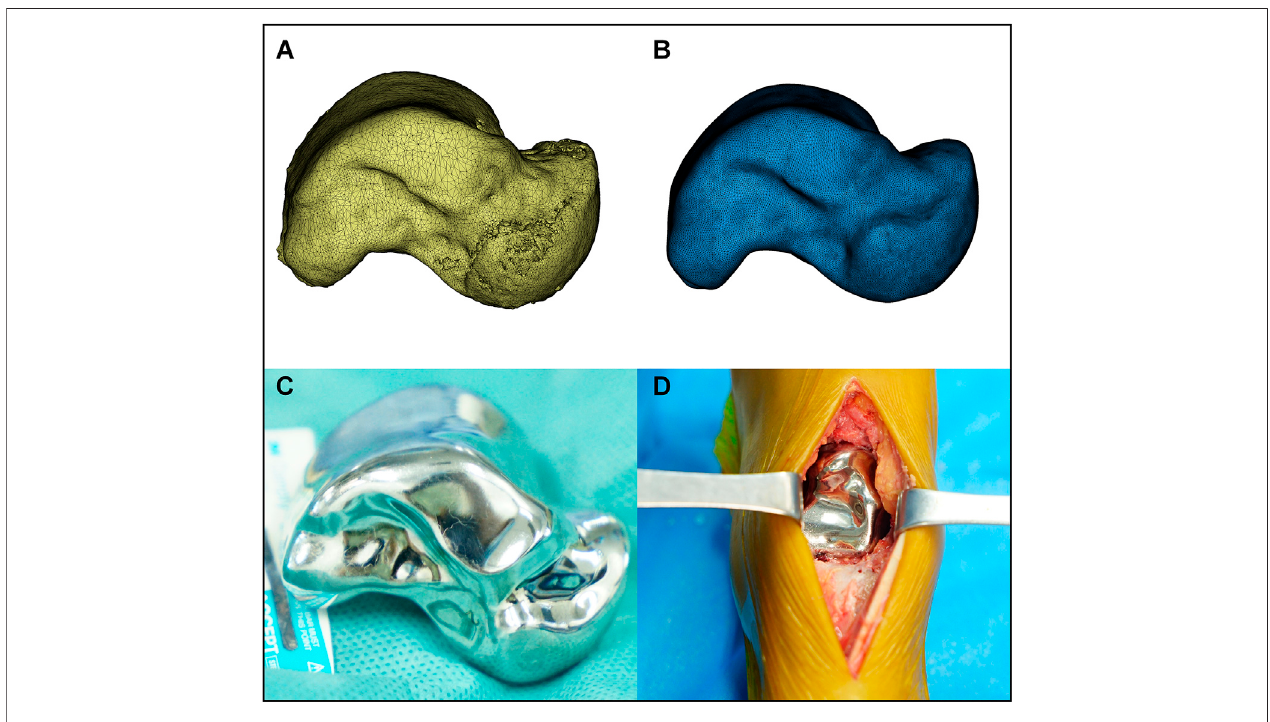
FIGURE 4 | The mirrored model of the unaffected talar was fi nely trimmed (A,B) then 3D printed via electron beam melting technology. The prosthesis ’ surfaces were then polished to reduce abrasion, and sterilized for clinical application (C) . TTR was performed in accordance with previously described studies (D)